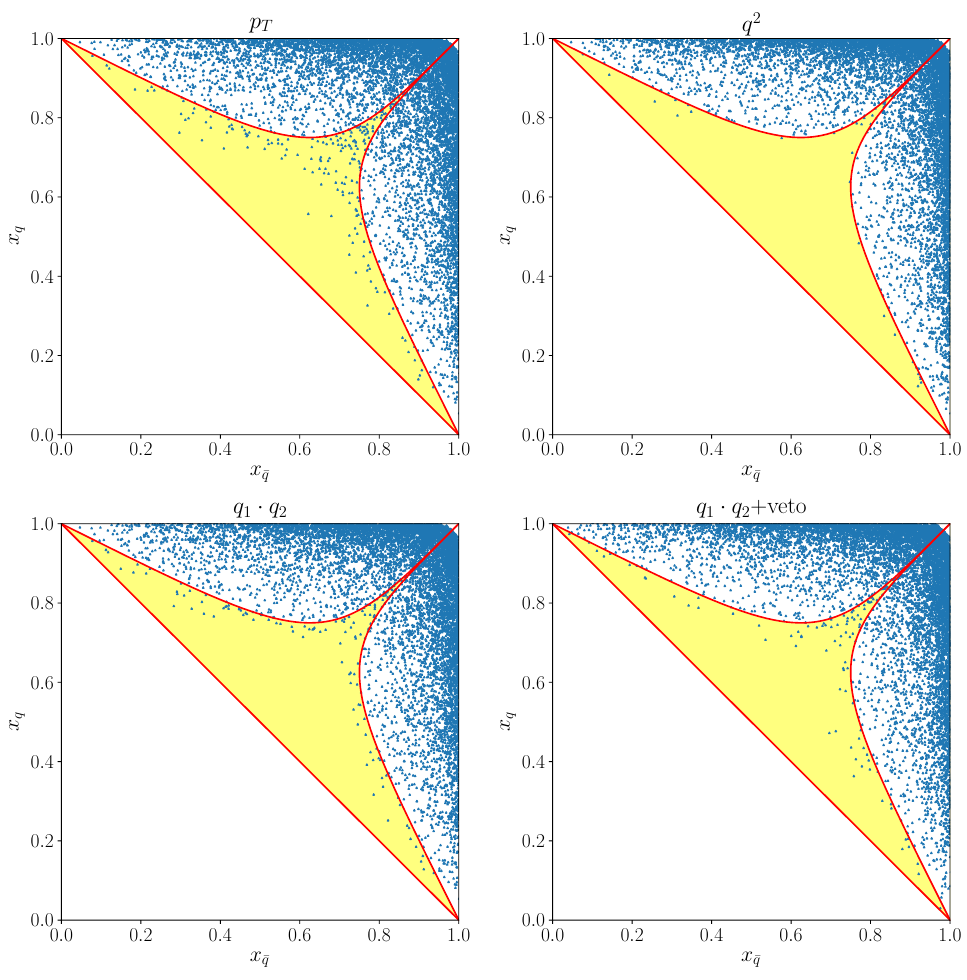
Figure 2 . Dalitz plot for e + e (cid:0) q (cid:22) q showing the region of phase space (cid:12)lled after multiple ! emission from the quark and anti-quark in the angular-ordered parton shower for several choices of the preserved quantity: p T (upper-left pane), q 2 (upper-right pane), dot-product (lower-left pane) and dot-product plus q 2 veto (lower-right pane). The red line illustrates the limits for the (cid:12)rst parton-shower emission and the yellow region corresponds to the dead zone . The variable x i is de(cid:12)ned to be 2 E i =Q , where E i is the energy of parton i and Q is the total energy, all de(cid:12)ned in the centre-of-mass of the